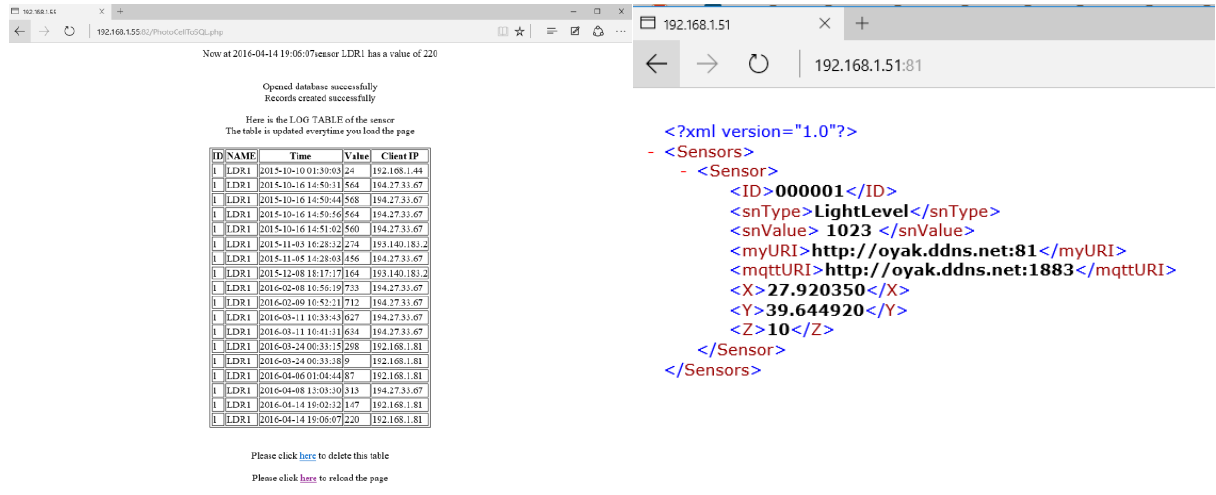
Figure 5: Simple Sensor Feed from Arduino (Genuino) UNO